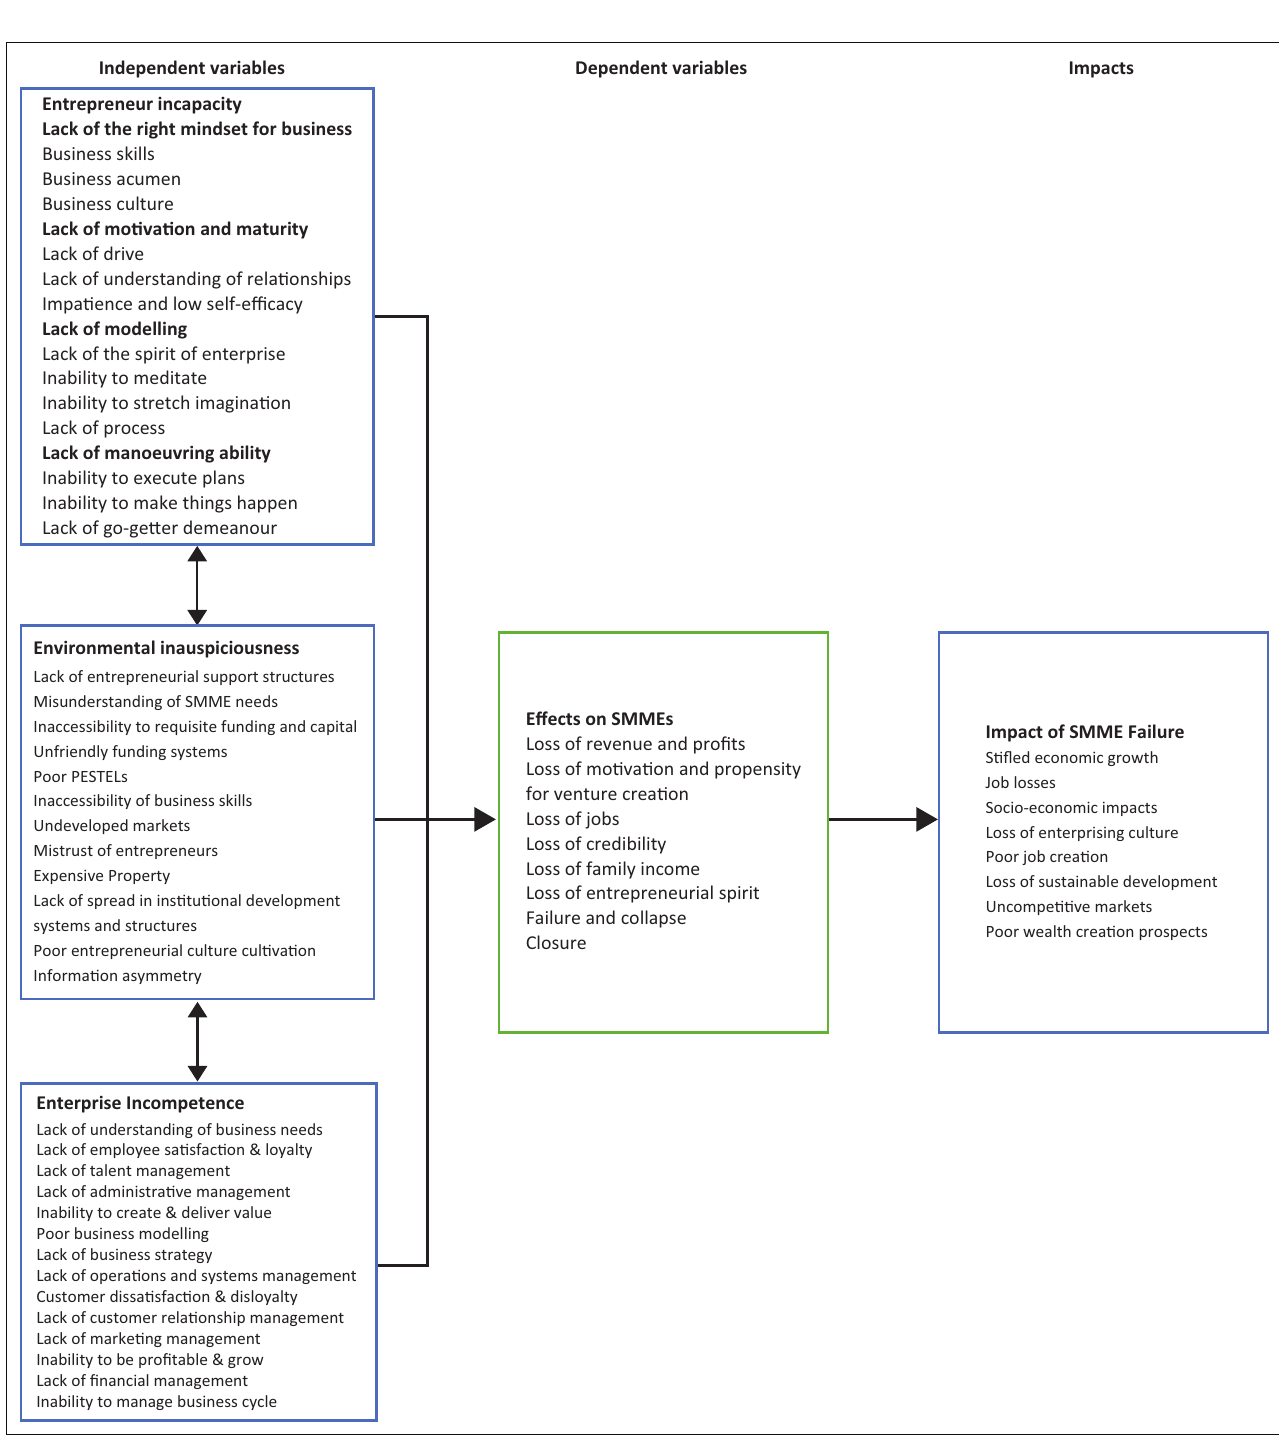
FIGURE 1: Hypothetical model – The causes and impact of small to micro and medium enterprise